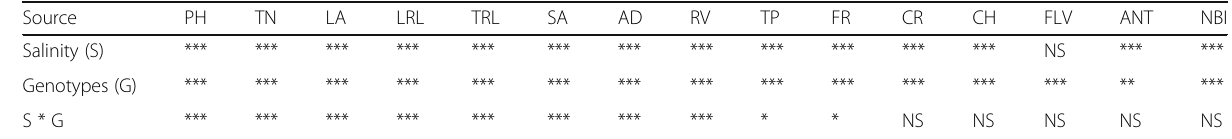
Table 1 Analysis of variance across the 74 tropical rice genotype, treatments and their interaction for the morpho-physiological traits measured at the final harvest, 37 days after sowing; plant height (PH), tillers number (TN), leaf area (LA), longest root length (LRL), total root length (TRL), root surface area (SA), average diameter (AD), root volume (RV), root tips (TP), forks (FR), crossings (CR), chlorophyll (CH), flavonoids (FLV), anthocyanin (ANT), and nitrogen balance index